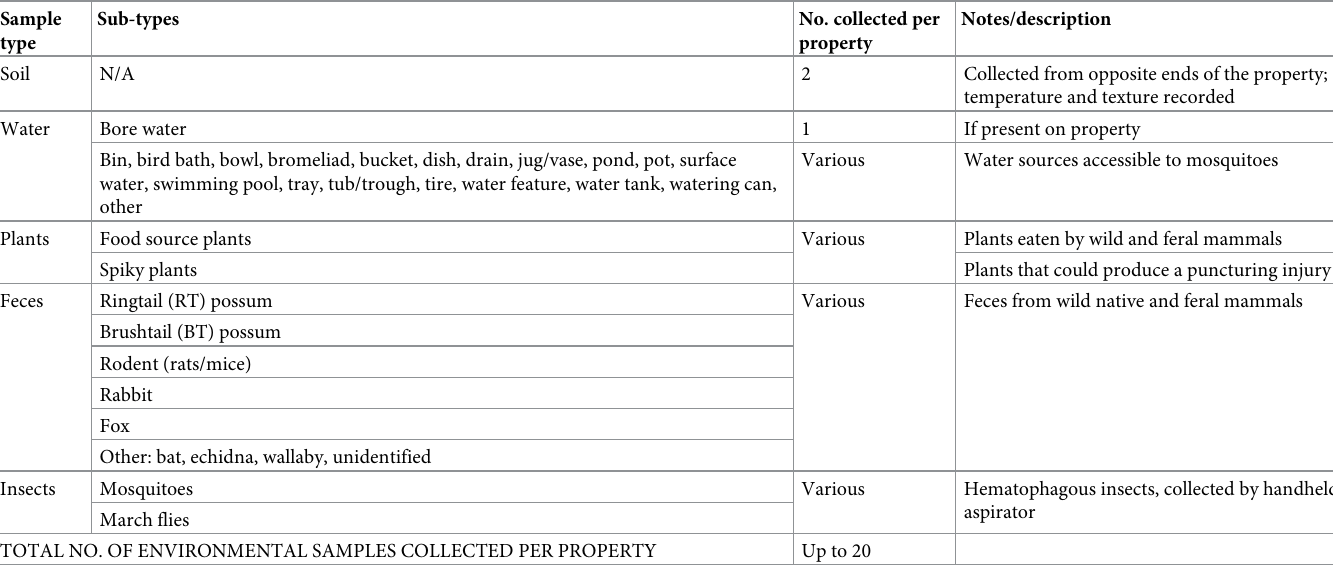
Table 5. Environmental field survey sample type categories. The mains water negative control is not included in the property sample